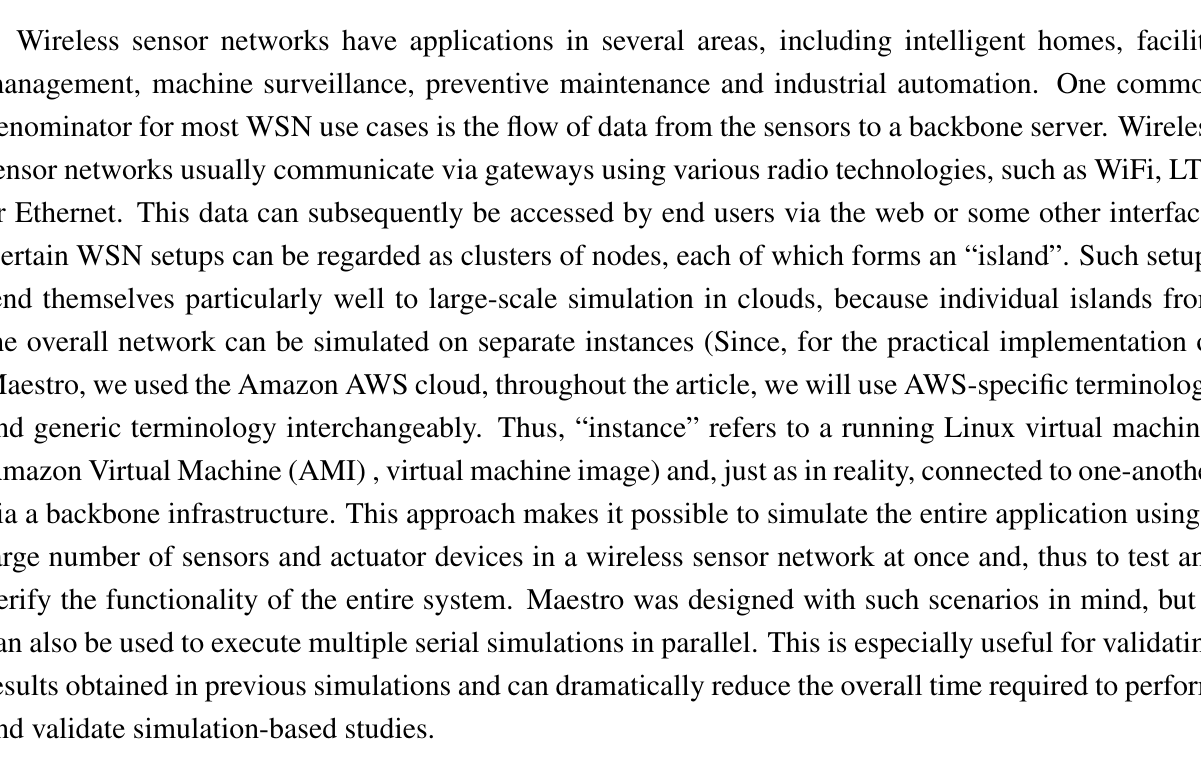
Figure 5. A schematic illustration of Maestro’s general